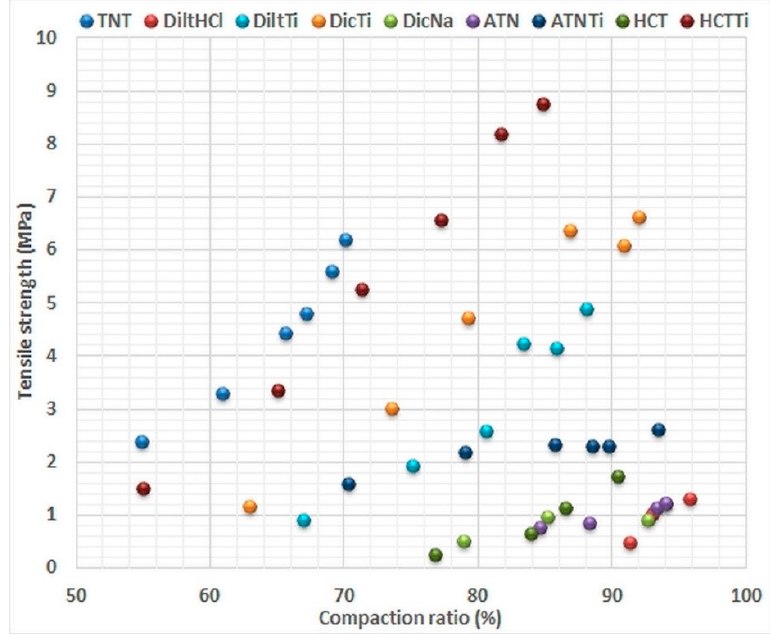
Figure 8. Evaluation of the tensile strength vs. The compaction ratio of the investigated materials compressed with 50, 100, 150, 200 and 250 MPa compression